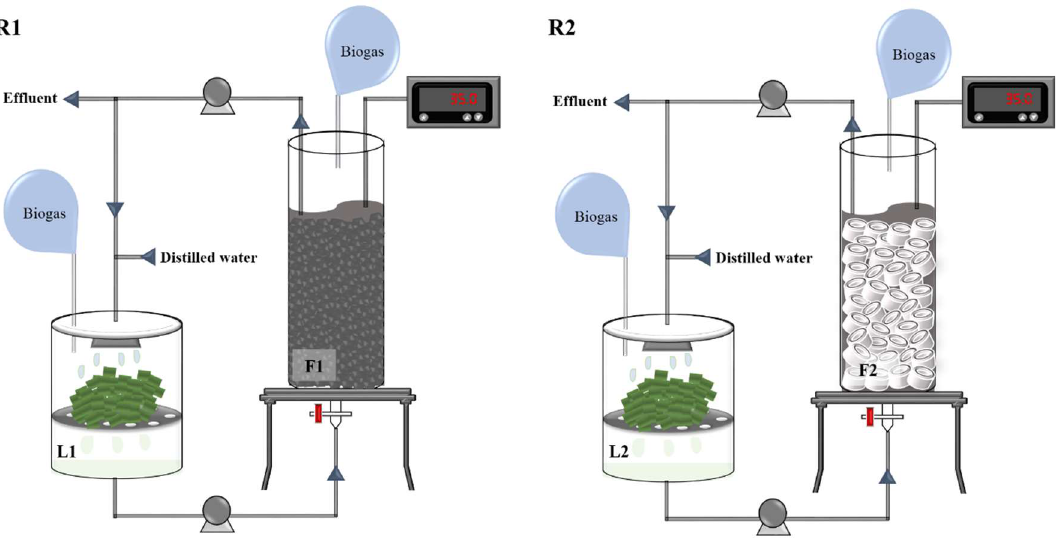
Figure 1. Schematic of the experimental LBR-AF systems with BFS grains (R1) or PVC rings (R2) as filter media. Leachate from each LBR was pumped into the bottom of the coupled AF, and the effluent from the AF was recirculated to the LBR.